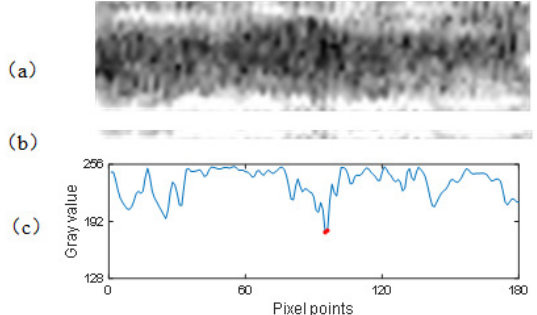
Figure 17. ( a ) Pipeline area; ( b ) pipeline project area; ( c ) the average gray value shedding damage recognition curve.